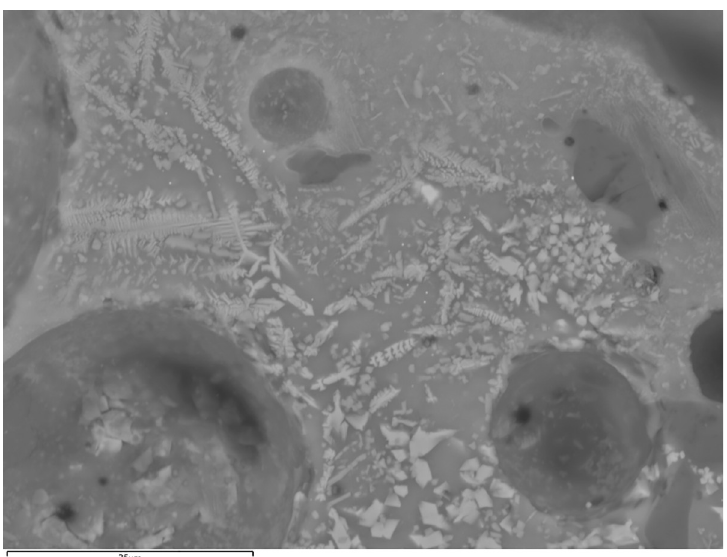
Fig 17. BSE micrograph of F11 showing different crystal formations of Fe aluminosilicates in the glassy matrix. Note that there are no metallic phases around. These crystals are located in very specific areas of the slag. (Scale = 25 μ m).